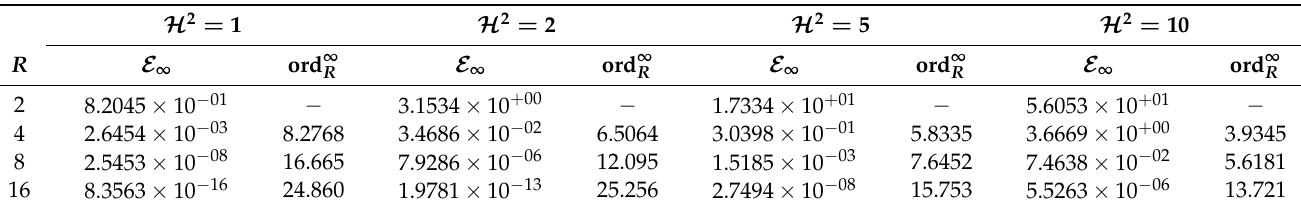
∞ 2 = 1,2,5,10, = 0.5, R with δ H